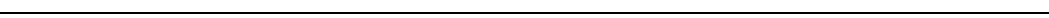
Fig. 6 CD271 regulates proliferation and adhesion via separate signaling axes. a Representation of the lentiviral vector for stable overexpression of the Intra Cellular Domain (ICD) of CD271. The viral backbone contains Green Fluorescent Protein (GFP) and infrared fl uorescent protein (iRFP) reporters under the SV40 and PGK promoters respectively, as well as the ICD overexpression cassette (ICD OE) or an empty vector (EV) under the CMV promoter. b FACS analysis for EdU incorporation in cells overexpressing ICD (ICD OE) compared to control cells (EV) ( n = 3; P value ≤ 0.05). c In vivo imaging of Nude mice injected with cells carrying the empty vector (EV) or the ICD overexpressing vector (ICD OE). The signal is from the iRFP present in the lentiviral backbone. d Quanti fi cation of the signal obtained by IVIS for iRFP (three mice for a total of six injections were analyzed for each conditions; P value_m1 ≤ 0.05, P value_m2 ≤ 0.05). Error bars indicate S.E.M. e Bright fi eld (upper panel) and fl uorescent micrographs (lower panel) of melanoma cells in culture 72 h after infection with the EV or ICD OE vector. Scale bars 100 µ m. f Crystal violet staining of adherent cells (upper panel) and suspension cells, after re-attachment on fi bronectin-coated plates (lower panel), carrying either the control vector (EV) or the ICD overexpressing vector (ICD OE). g Quanti fi cation of adherent and suspension cells after infection with EV or ICD OE constructs ( n = 3, P value_adh.cells ≤ 0.05, P value_susp.cells > 0.05). Error bars indicate S.D. h FACS analysis for EdU incorporation in cells infected with CMVTOEV or CMVTOCD271 constructs and transfected with sicontrol or siTrk-A. One day after siRNA transfection the cells were treated with doxycycline (1 μ g/ml) for 24 h. Cells were then pulsed with EdU for 30 min and collected for FACS analysis ( n = 3; P value ≤ 0.05). i Crystal violet staining of suspension cells (forced to reattach on fi bronectin-coated plates) infected with CMVTOEV or CMVTOCD271 and transfected with siControl (upper panel) or siTrk-A (lower panel). The cells were treated, as described in h . j Quanti fi cation of suspension cells (CMVTOEV or CMVTOCD271 infected) after siRNA transfection and doxycycline administration (as described in h ) ( n = 3, P value ≤ 0.05, P value ≤ 0.001). Error bars indicate S.D. All experiments done with cell line